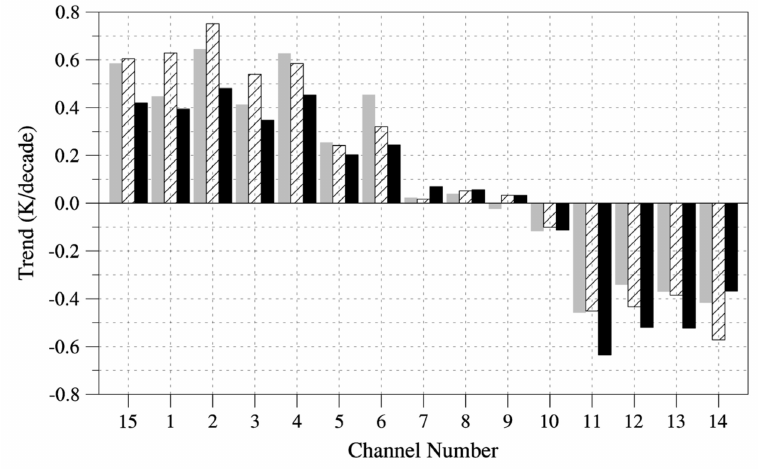
Figure 14. Decadal linear trends for all AMSU-A channels from the original data (solid grey bar) after the inter-sensor bias correction (slashed black bar) and after the inter-decadal diurnal correction (solid black